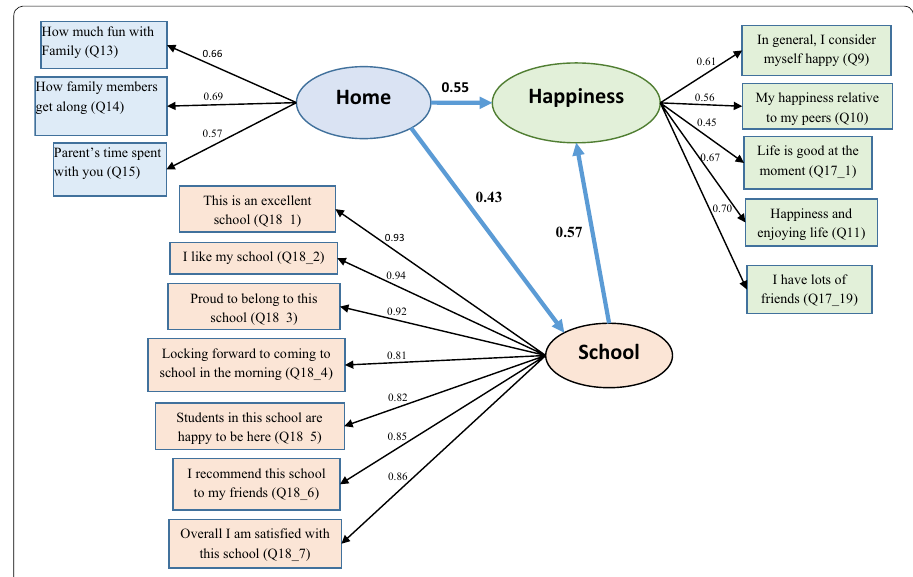
Fig. 1 The general structural equation model